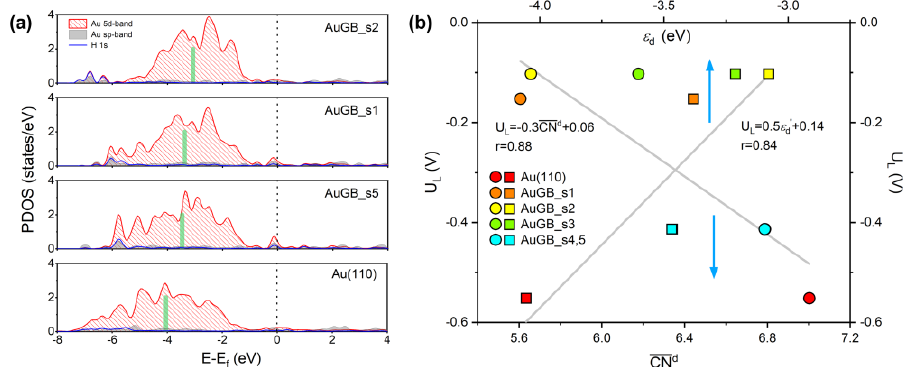
Figure 7. ( a ) Au 5 d orbital − PDOS on active sites on Au(110) with and without GBs. The Fermi energy ( E f ) is set to zero and is represented by a black vertical dashed line. The green, thick bar represents the ε d of a specific atom on Au(110) surface in the absence or presence of GBs. ( b ) The trends in U L for HER on different GBs sites as a function of CN̅̅̅̅ 𝑑 and ε d . The perfect Au(110) plane is also presented for comparison.